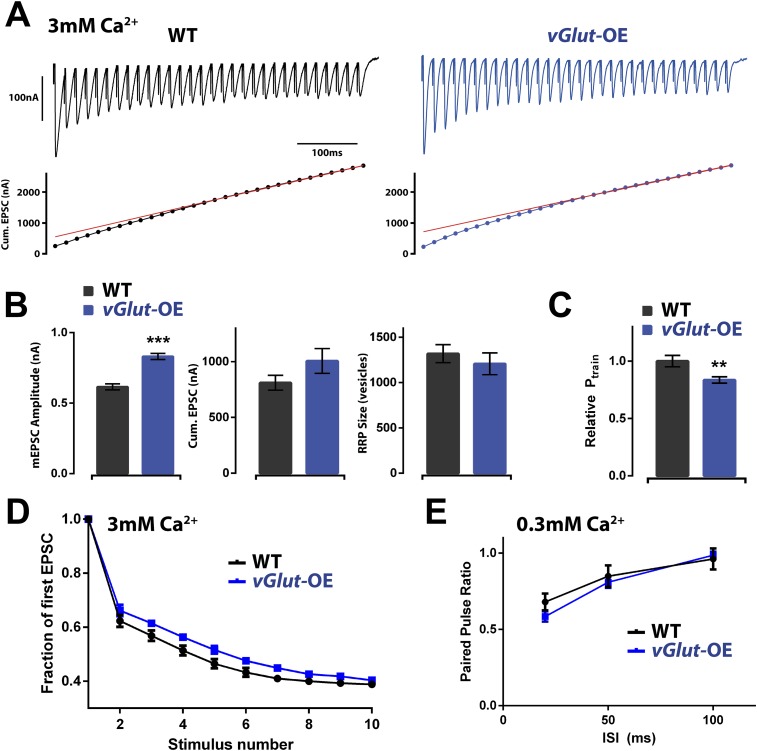
Effects of PHD on RRP size and Pr.(A) Top: representative EPSC trains from wild type (left) and vGlut-OE (right) animals in response to 60 Hz stimulation (30 stimuli). Bottom: cumulative EPSC amplitude for the traces shown. The line fit to the cumulative EPSC data and back extrapolated to time 0 is shown in red (see ‘Materials and methods’). (B) vGlut-OE animals had increased mEPSC amplitudes (p < 0.0001), and cumulative EPSC amplitudes that trended upward (p = 0.16). The calculated RRP size was unchanged (p = 0.49). (C) The relative probability of release as calculated by the train method was decreased in vGlut-OE animals at 3 mM external Ca2+ (p = 0.008). (D) vGlut-OE animals were not significantly more resistant to depression over the first 10 stimuli of the 60 Hz trains described (a single phase decay function was fitted to points 2–10 for each muscle, generating a decay constant which was averaged across each genotype; p = 0.24). (E) The probability of release was unchanged in vGlut-OE animals as measured by the paired pulse ratio at 0.3 mM external Ca2+ (n = 5 for vGlut-OE, n = 6 for wt). For (A) through (D): n = 9 for WT, n = 10 for vGlut-OE and [Ca]e = 3 mM. Error bars = SEM for all.